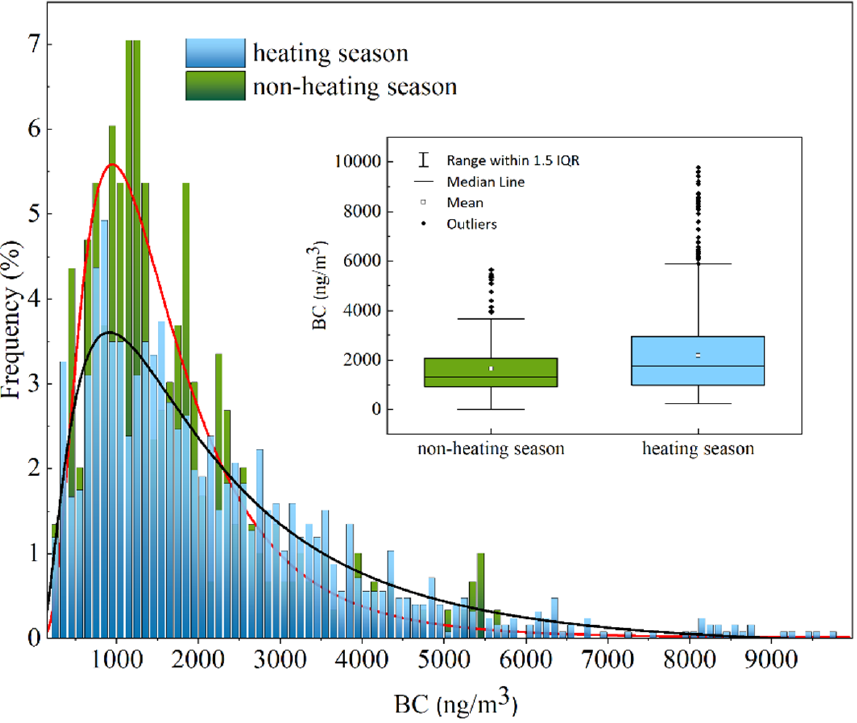
Figure 2. Frequency distribution histogram of the hourly mean concentration of black carbon (BC) in the heating and non-heating seasons.